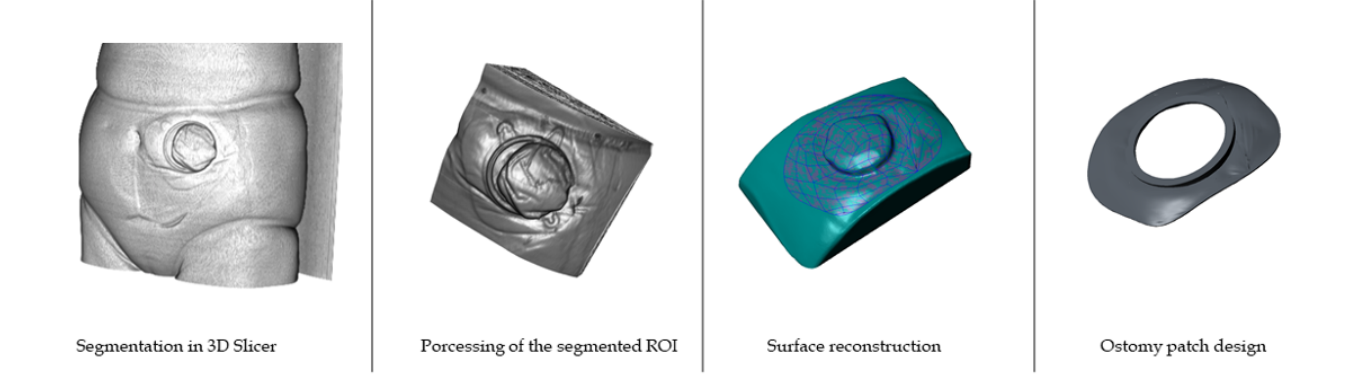
Figure 8. Main steps for the design of the personalized ostomy patch via CT